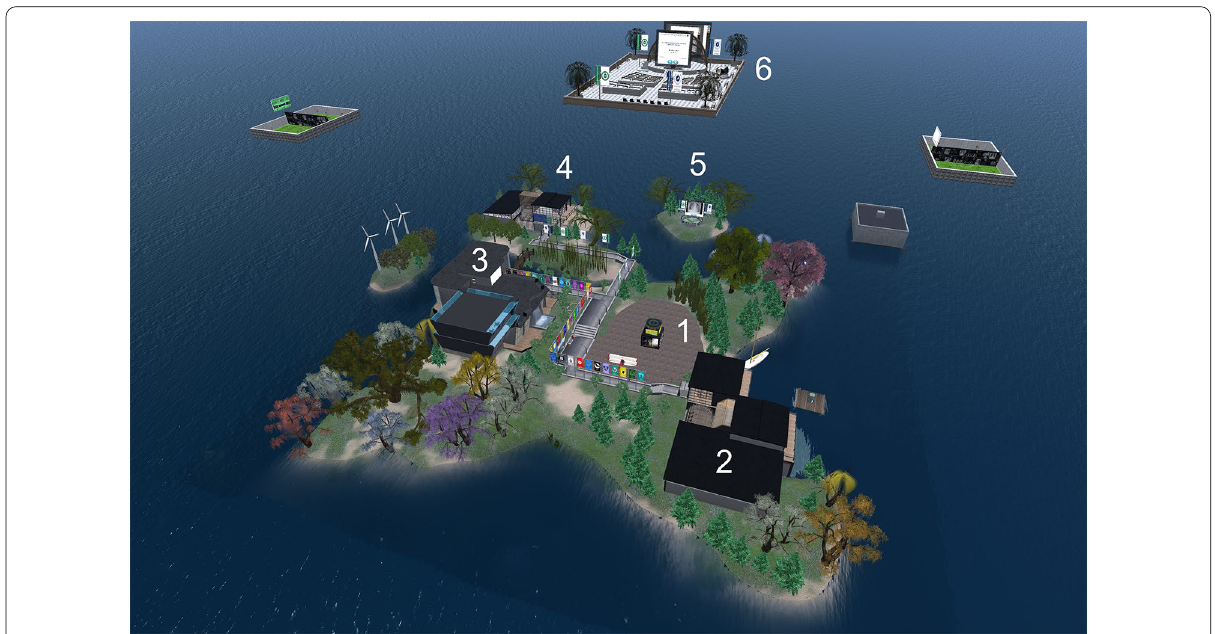
Fig. 1 Aerial view of the Medical Master Island, in which the following are indicated: (1) the central esplanade, next to the arrival point; (2) the postgraduate building; (3) the Medical Master Conference Center; (4) the undergraduate building; (5) a small open‑air auditorium, on an islet; and (6) a floating auditorium, in the